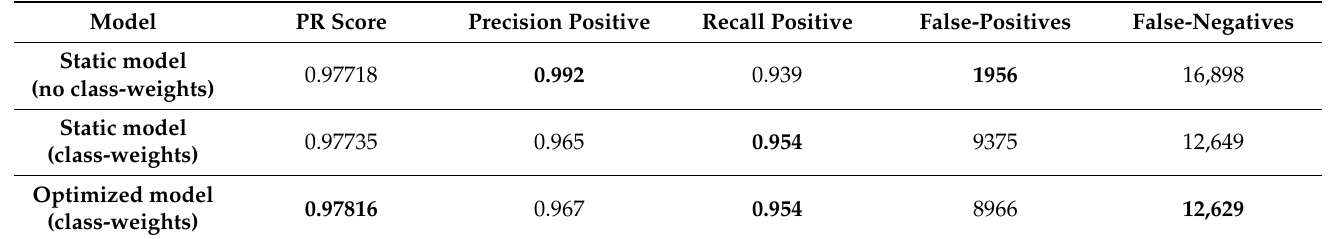
Table 3. DNN models